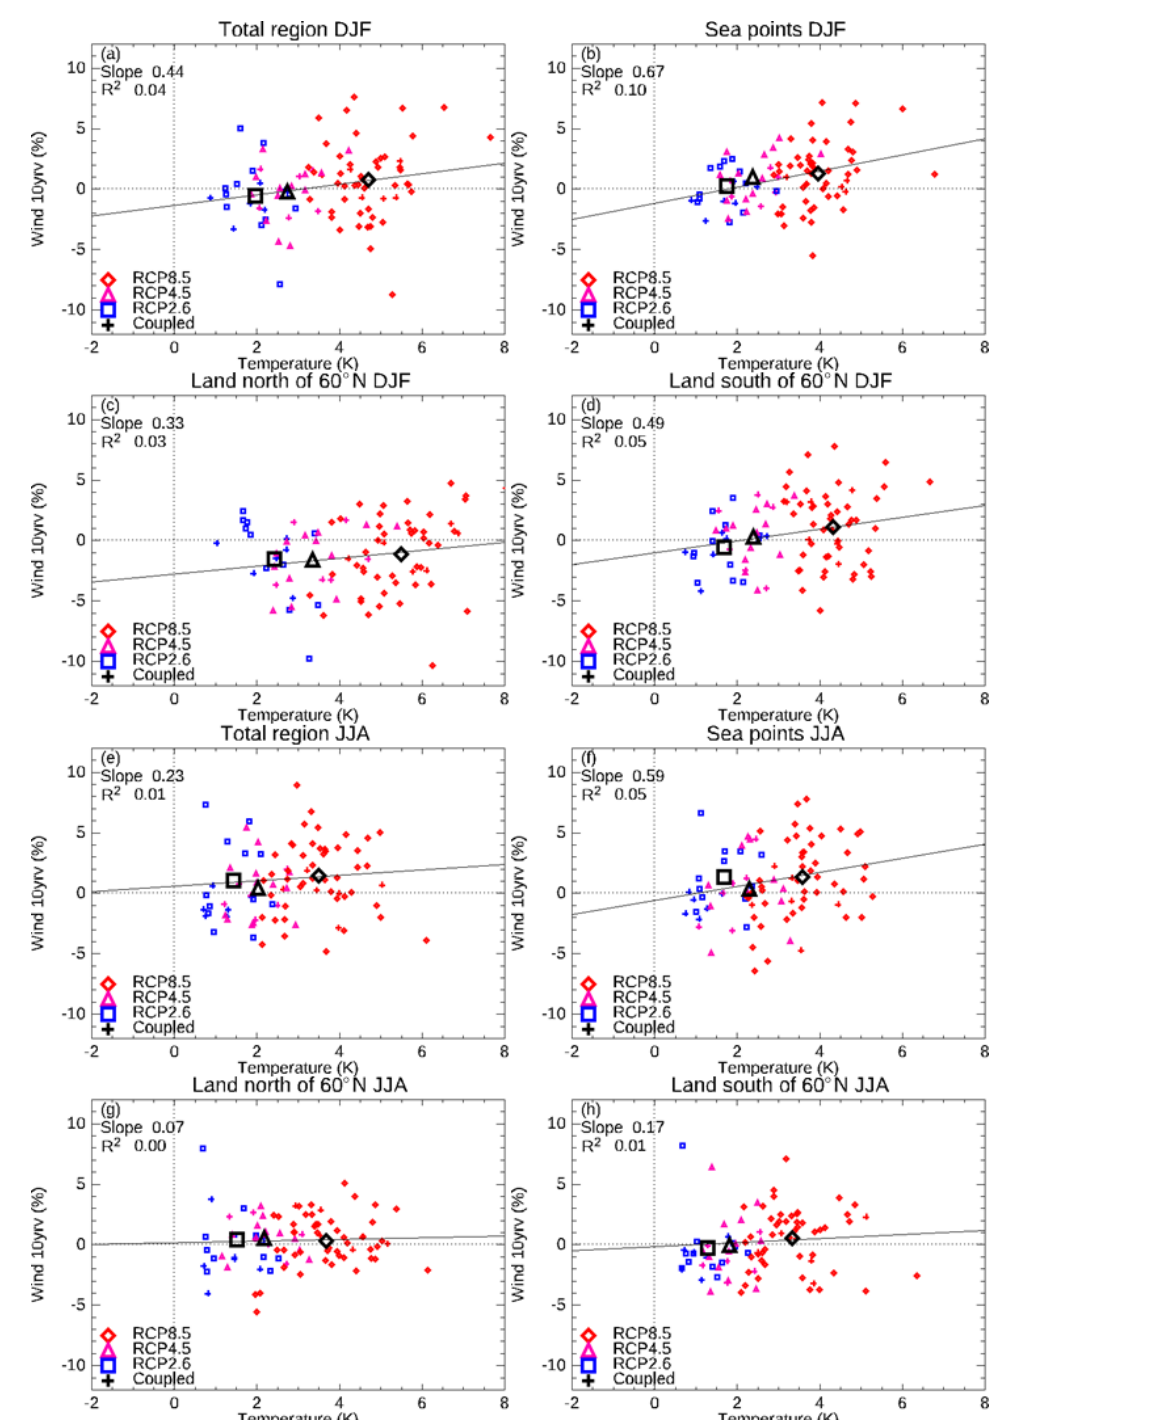
Figure 6. Relative change 1981–2010 to 2071–2100 of the 10-year return value of 10m daily maximum wind speed against temperature change for individual models and all scenarios. Scenario means are indicated by larger black symbols. Blue squares: RCP2.6; pink triangles: RCP4.5; red diamonds: RCP8.5; green crosses: the ENSEMBLES simulations analysed in BACC II (2015). Plus signs in colours correspond- ing to the scenario: the RCA4-NEMO atmosphere–ocean coupled simulations. Calculation performed for subsets of the Baltic catchment: the entire catchment; sea points; land points north and south of 60 ◦ N, respectively. Panels (a) – (d) show winter; panels (e) – (h) show summer. The lines, with quoted slope and squared correlation coefficient, are best fits to all EURO-CORDEX and ENSEMBLES data but do not include coupled-model